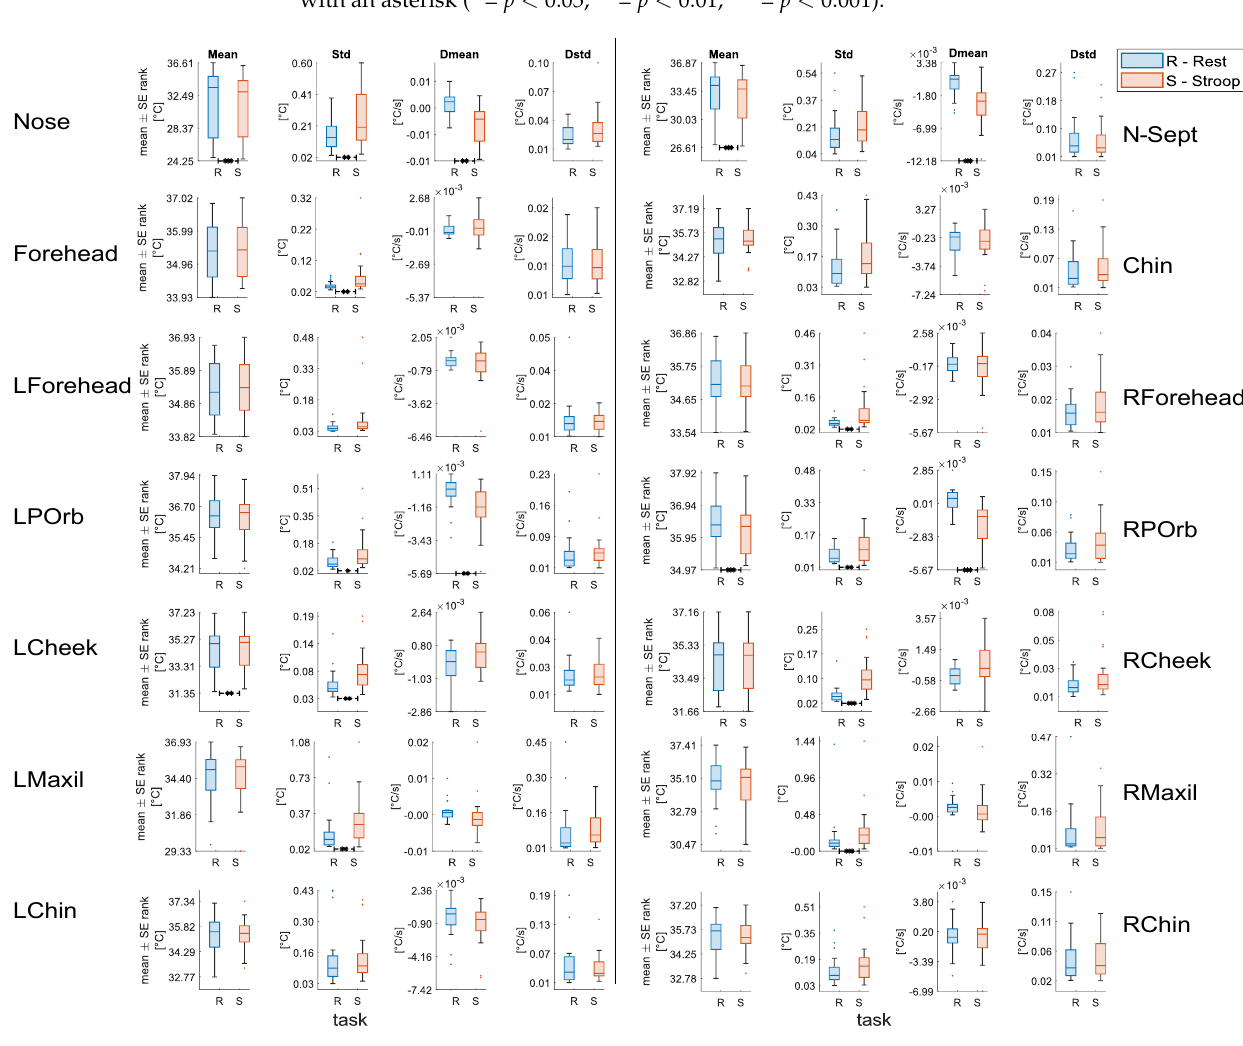
Figure 8. Statistical comparison for each of the thermal features extracted. Significant differences between Rest and Stroop sessions after the Wilcoxon signed rank test with FDR-BH correction are highlighted with an asterisk (* = p < 0.05; ** = p < 0.01; *** = p <